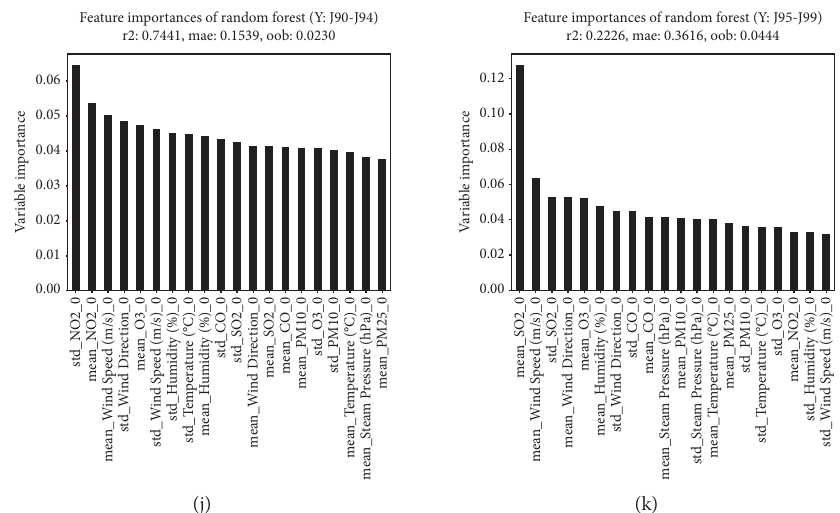
Figure 2: Analysis of the correlation between respiratory disease patients’ visit to the ED and air pollution and weather variables (day 0). (a) [J00-J06] Acute upper respiratory infections. (b) [J09-J11] Influenza. (c) [J12-J18] Pneumonia. (d) [J20-J22] Other acute lower respiratory infections. (e) [J30-J39] Other diseases of upper respiratory tract. (f) [J40-J47] Chronic lower respiratory diseases. (g) [J60-J70] Lung diseases due to external agents. (h) [J80-J84] Other respiratory diseases principally affecting the interstitium. (i) [J85-J86] Suppurative and necrotic conditions of lower respiratory tract. (j) [J90-J94] Other diseases of pleura. (k) [J95-J99] Other diseases of the respiratory system.